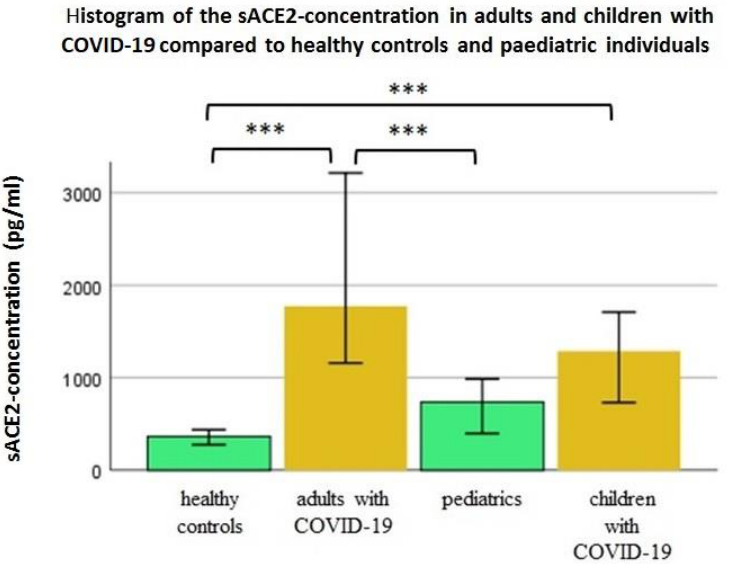
Figure 3. Comparison of the sACE2-cocentration in different age-groups with and without COVID-19, Mann-Whitney-U-test, *** significant difference: p < 0.001 (median and 95% confidence interval shown).